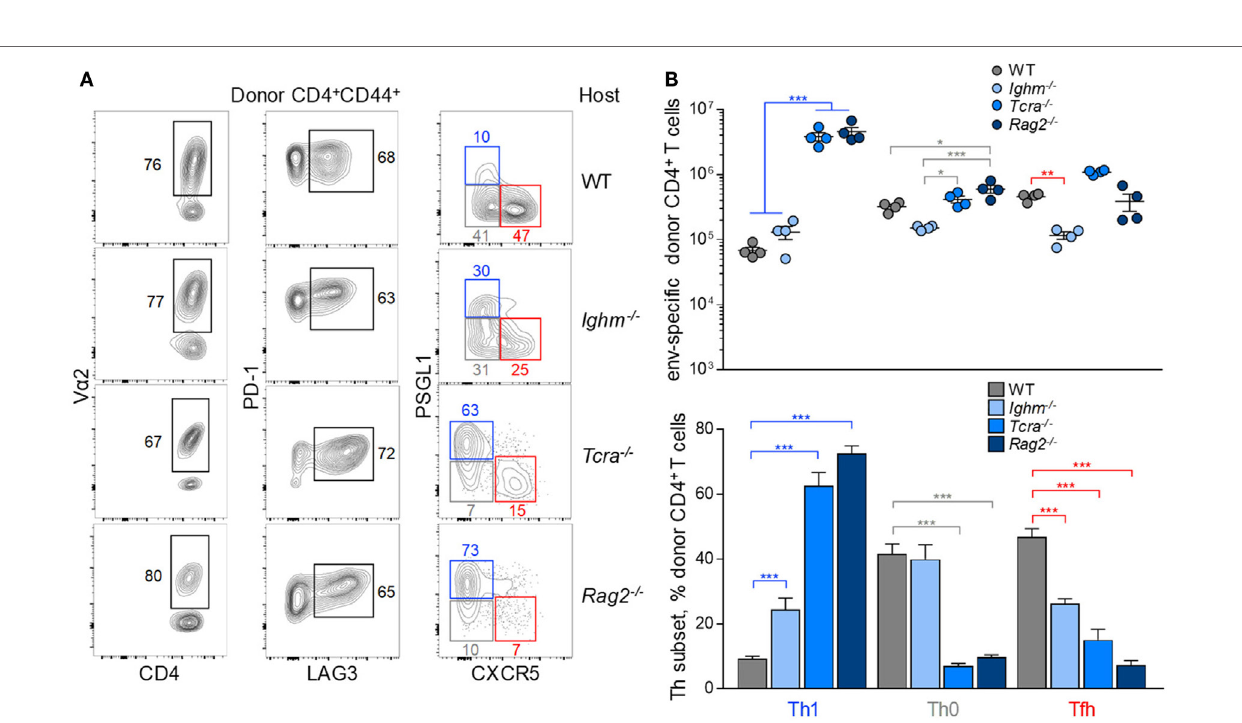
FigUre 6 | Effect of lymphocyte interaction on the follicular helper (Tfh) response to F-MLV env. (a) Flow cytometric analysis of V α 2, PD-1, LAG3, PSGL1, and CXCR5 expression in env-reactive CD4 + T cells isolated from the spleens of the indicated recipient mice on day 7 post transfer and intermediate Friend virus (FV) infection (WT host, n = 12; Ighm − / − host, n = 6; Tcra − / − host, n = 6; Rag2 − / − host, n = 7). (B) Absolute number ( top ) and mean frequency ( ± SEM) ( bottom ) of T helper (Th) subsets, defined by PSGL1 and CXCR5 expression, in env-reactive donor CD4 + T cells from the same donor cells as in (a)